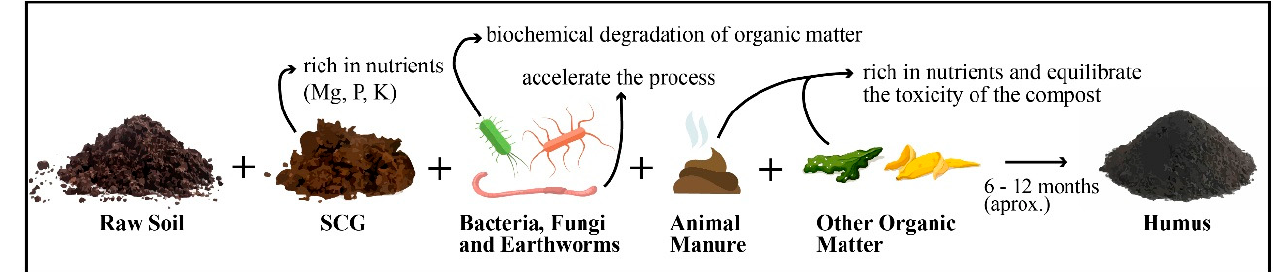
Figure 3. Composting scheme with SCG and other commonly used elements.